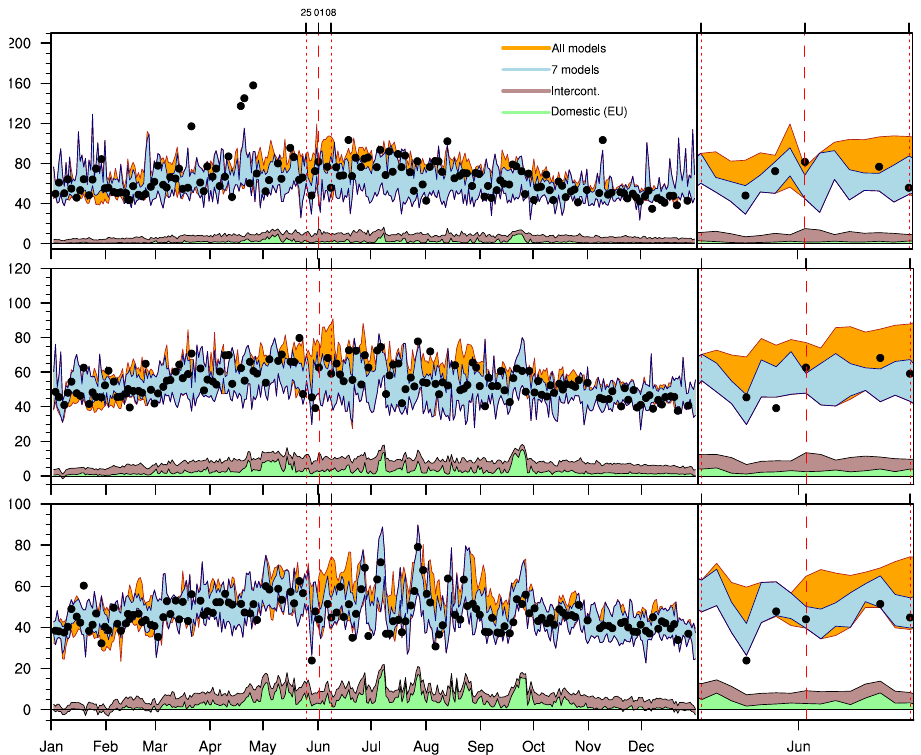
Fig. 8: Daily range of calculated ozone and stacked intercontinental (NA, EA and SA) and domestic (EU) contributions from at Uccle in the UT (500 - 300hPa) top, MT (700 - 500hPa) middle and LT (900 - 700hPa) bottom panel. The focused panels on the right hand side are centred around the June 1. episode, highlighted in Section 4.1.2 and bounded by red lines in the Figure. The range for the first seven models listed in Table 1 are shown in blue. The additional range, including all models in Table 1, are shown in orange. Ozone measurements from ozonesondes are marked as black dots. The model mean stacked contributions (multipl. by 5) from domestic (EU) and intercontinental (NA, EA and SA) are also shown.